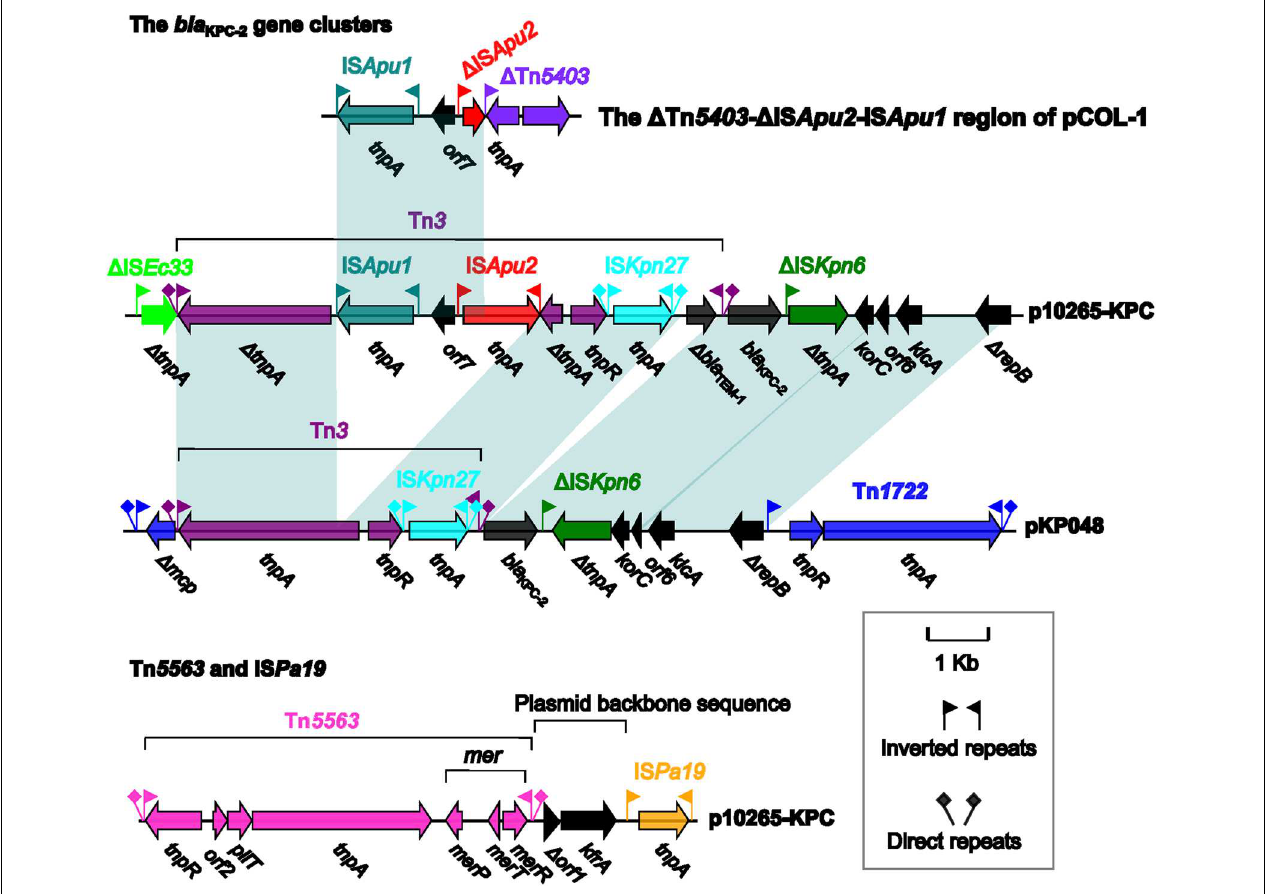
FIGURE 2 | Accessory modules of p10265-KPC and comparison with related genetic contents. Genes are denoted by arrows and colored based on gene function classification. Shading regions denote shared regions of homology ( > 95% nucleotide